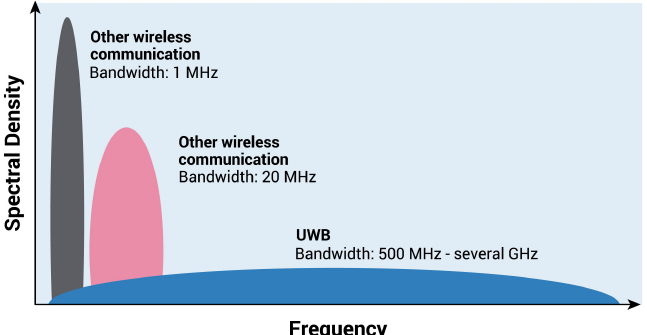
Figure 5. The wide UWB power spectrum results in a low power consumption compared to other technologies. (Source: FiRa